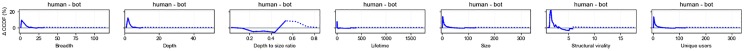
Differences in information spread for root tweets posted by users predicted as humans versus bots.Differences are taken between CCDFs for humans versus bots. Spikes above 0 demonstrate larger numbers for humans. Spikes below 0 demonstrate larger numbers for bots.